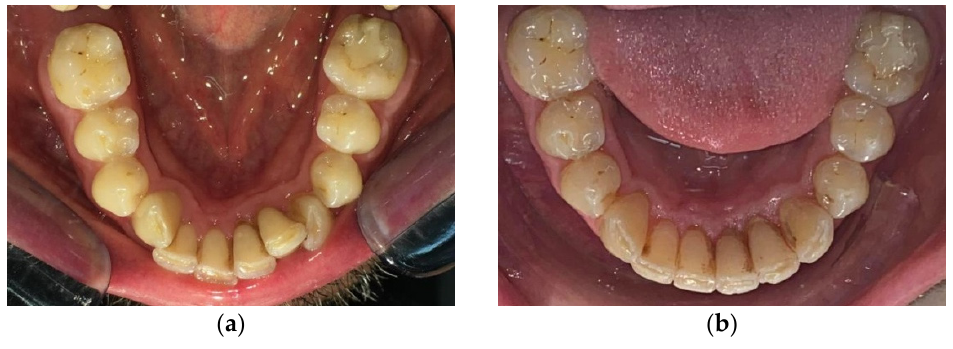
Figure 2. ( a ) Lower arch at T0, ( b ) lower arch at T1.